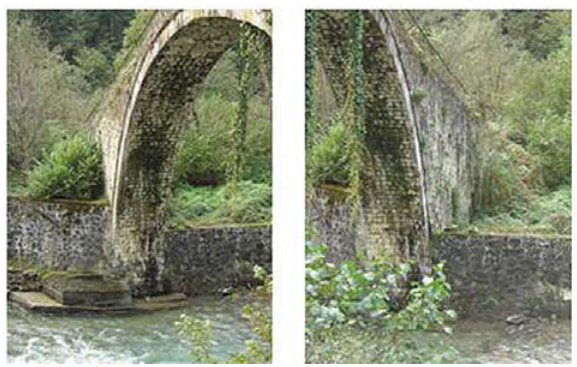
Fig. 10. Some view of stiffness at the side walls of the bridge